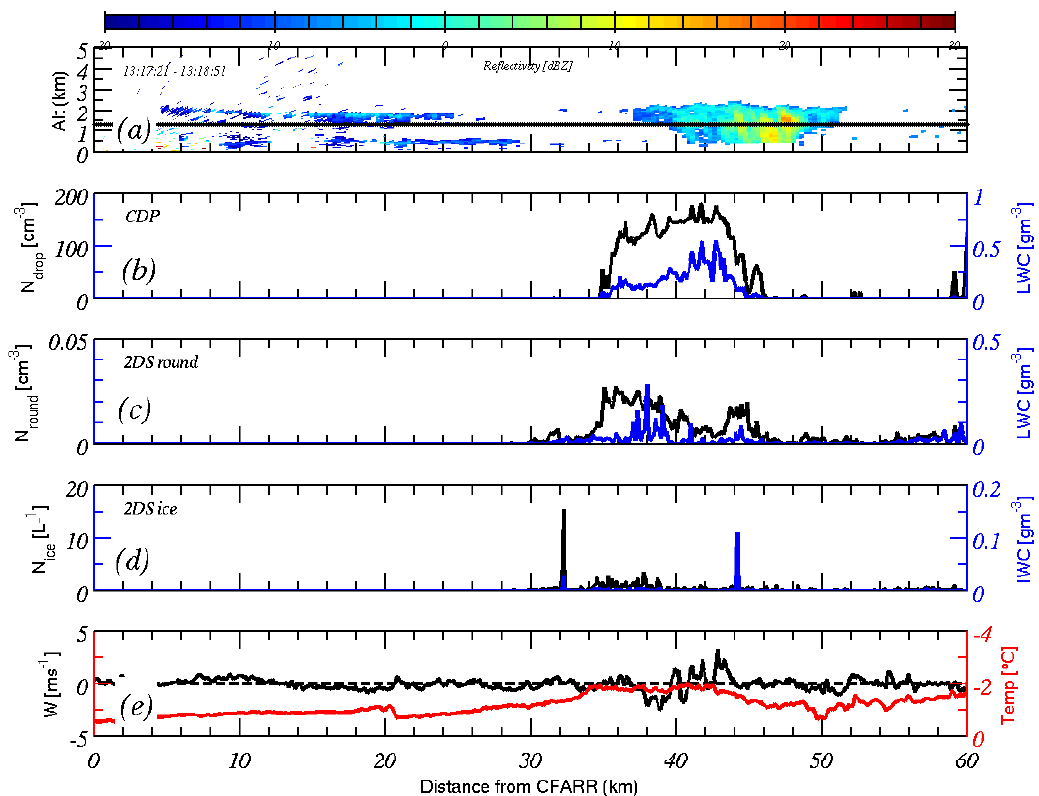
Fig. 4. Reflectivity from the 3GHz CAMRa RHI scan along the 253 ◦ radial and GPS altitude (a) – (top panel, time of scan indicated in top left). In situ total particle number concentration (black lines, left axes) and mass loadings (blue lines, right axes) measured by the CDP (b) as a function of distance from CFARR; 2DS round classification (c) , and 2DS ice classification (d) . Also shown (e) ; in situ temperature from the de-iced Rosemount sensor; vertical wind speed from the 5-hole pressure port turbulence probe, all from run R1, inbound to CFARR.